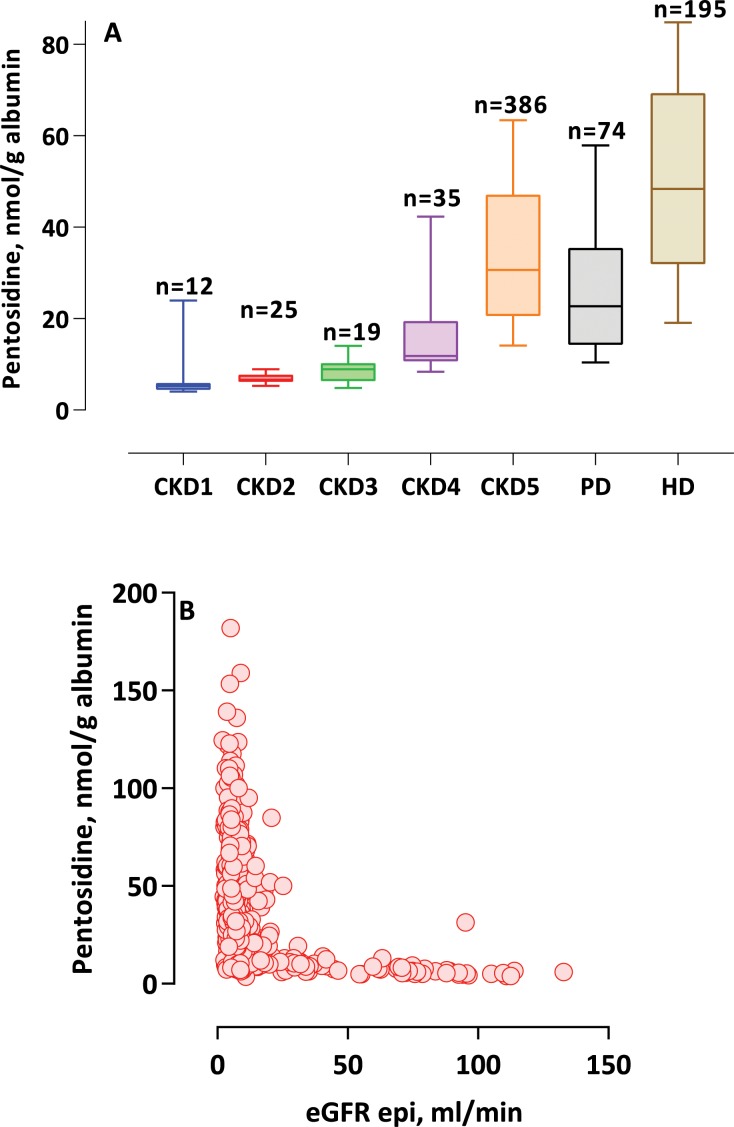
(A) Baseline plasma pentosidine levels, corrected for albumin level, for each studied cohort including all individuals (n = 746) and shown as box-and-whisker plots depicting median, and 10th to 90th percentile.(B)Correlation between plasma pentosidine level, corrected for albumin, and estimate glomerular filtration rate (eGFR) based on chronic kidney disease epidemiology collaboration (CKD-EPI) formula or in haemodialysis patients assuming eGFR zero in all investigated individuals (n = 746).